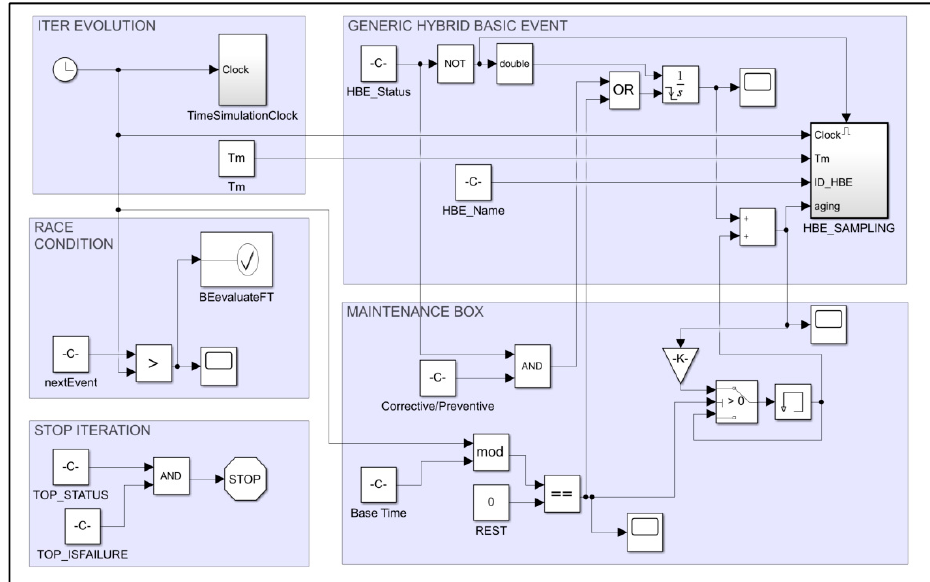
Figure 4. Maintenance Box coupled with the “generic hybrid basic event” block.